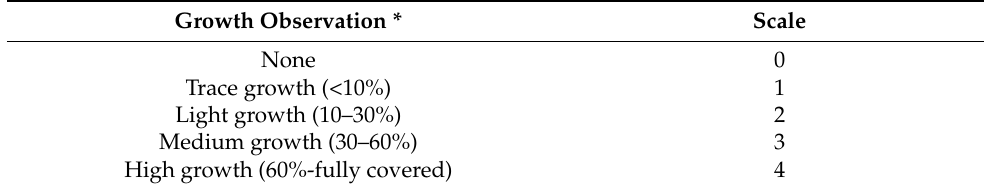
Figure 5. Films’ biodegradability observed on days 0 and 28 after spore mixture inoculation, comprising Aspergillus niger , Penicillium pinophilum , Chaetomium globosum , Gliocladium virens and Aureobasidium pullulans . ( A ) Cellulose–Chitosan, ( B ) Cellulose–Cellulose nanocrystals–Chitosan, ( C ) Chitosan, ( D ) Filter paper and ( E ) Negative control films were placed in a non-inoculated medium. The numbers below each image correspond to the growth scale described in Table 5. Table 5. Fungal growth evaluation scale for the biodegradability test. Growth Observation *